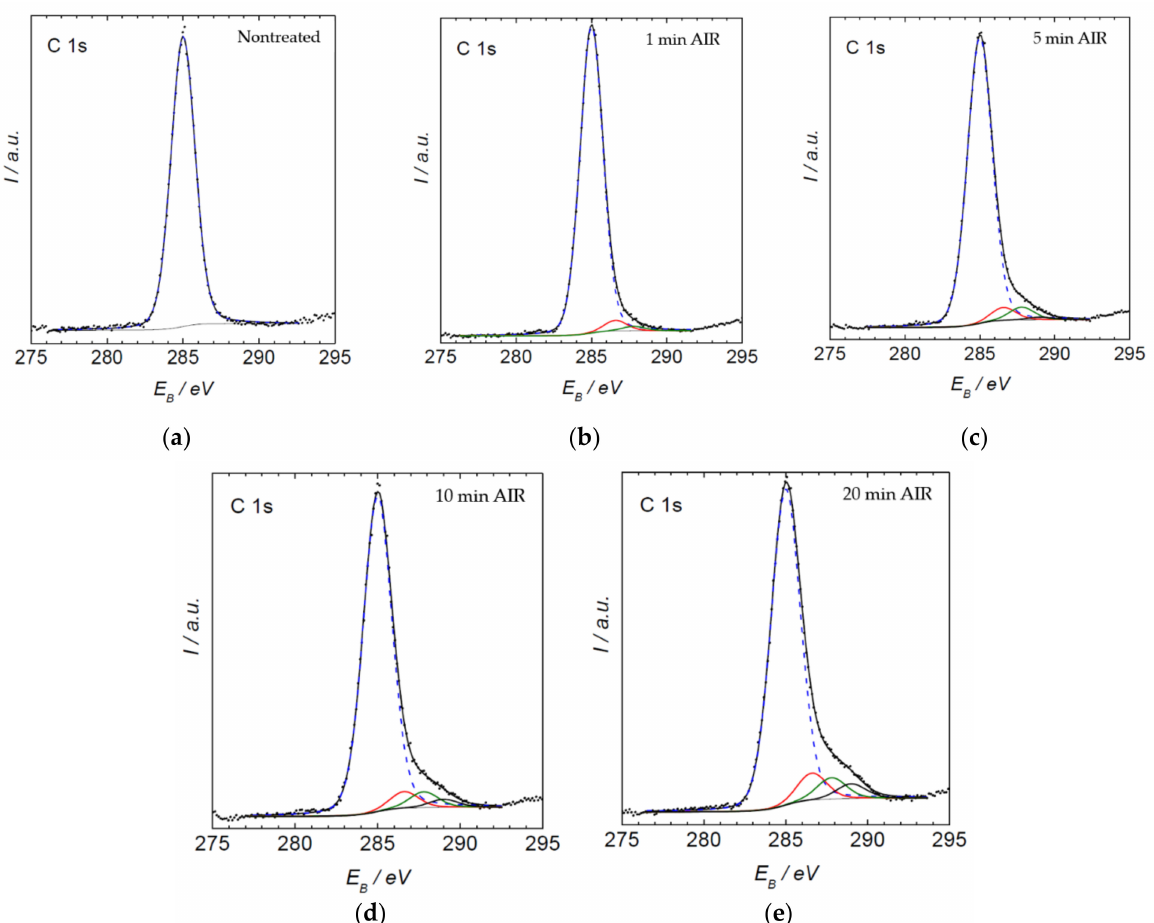
Figure 4. C1s spectrum of PE powder ( a ) non-treated and plasma-treated in air plasma for ( b ) 1 min, ( c ) 5 min, ( d ) 10 min and ( e ) 20 min. Blue line C-C bond, red line C-O bond, green line C=O bond, black line O-C=O